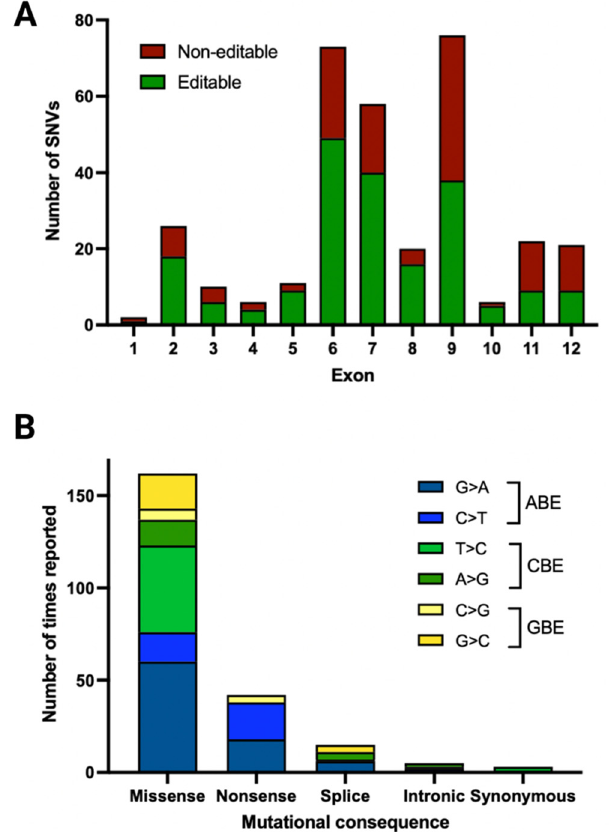
Figure 4. Pathogenic SNVs by exon location and editability as well as mutational consequence. ( A ) 57% of pathogenic SNVs are present in exon 6, 7 and 9, which corresponds to the length of these exons relative to the entire coding sequence (cds). Of the pathogenic SNVs in exon 6, 67% are editable. ( B ) The most common pathogenic, editable SNV is a missense mutation, followed by nonsense and splice site mutations.